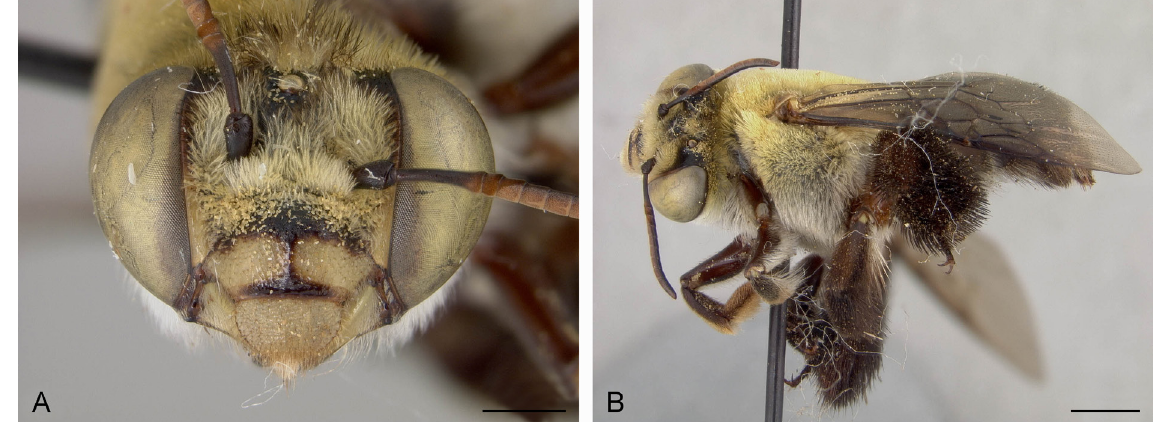
Fig. 13. Centris ruae Cockerell, 1949, holotype, ♀ (NMNH; USNM ENT 00534212). A . Frontal view. B . Habitus, lateral view. Scale bars: A = 1 mm; B = 2